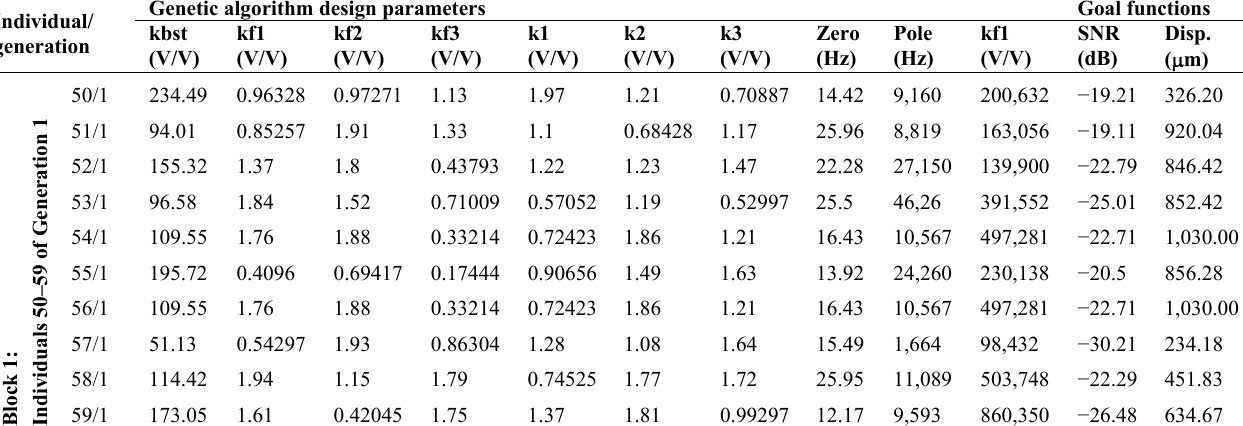
Table 3. Example Individuals in the Evolutionary